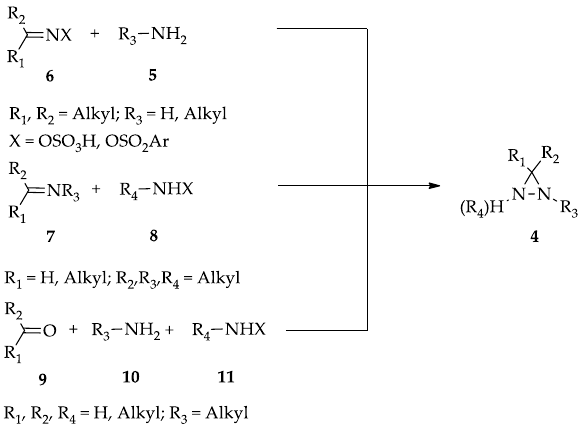
Figure 2. General construction of monocyclic diaziridines.